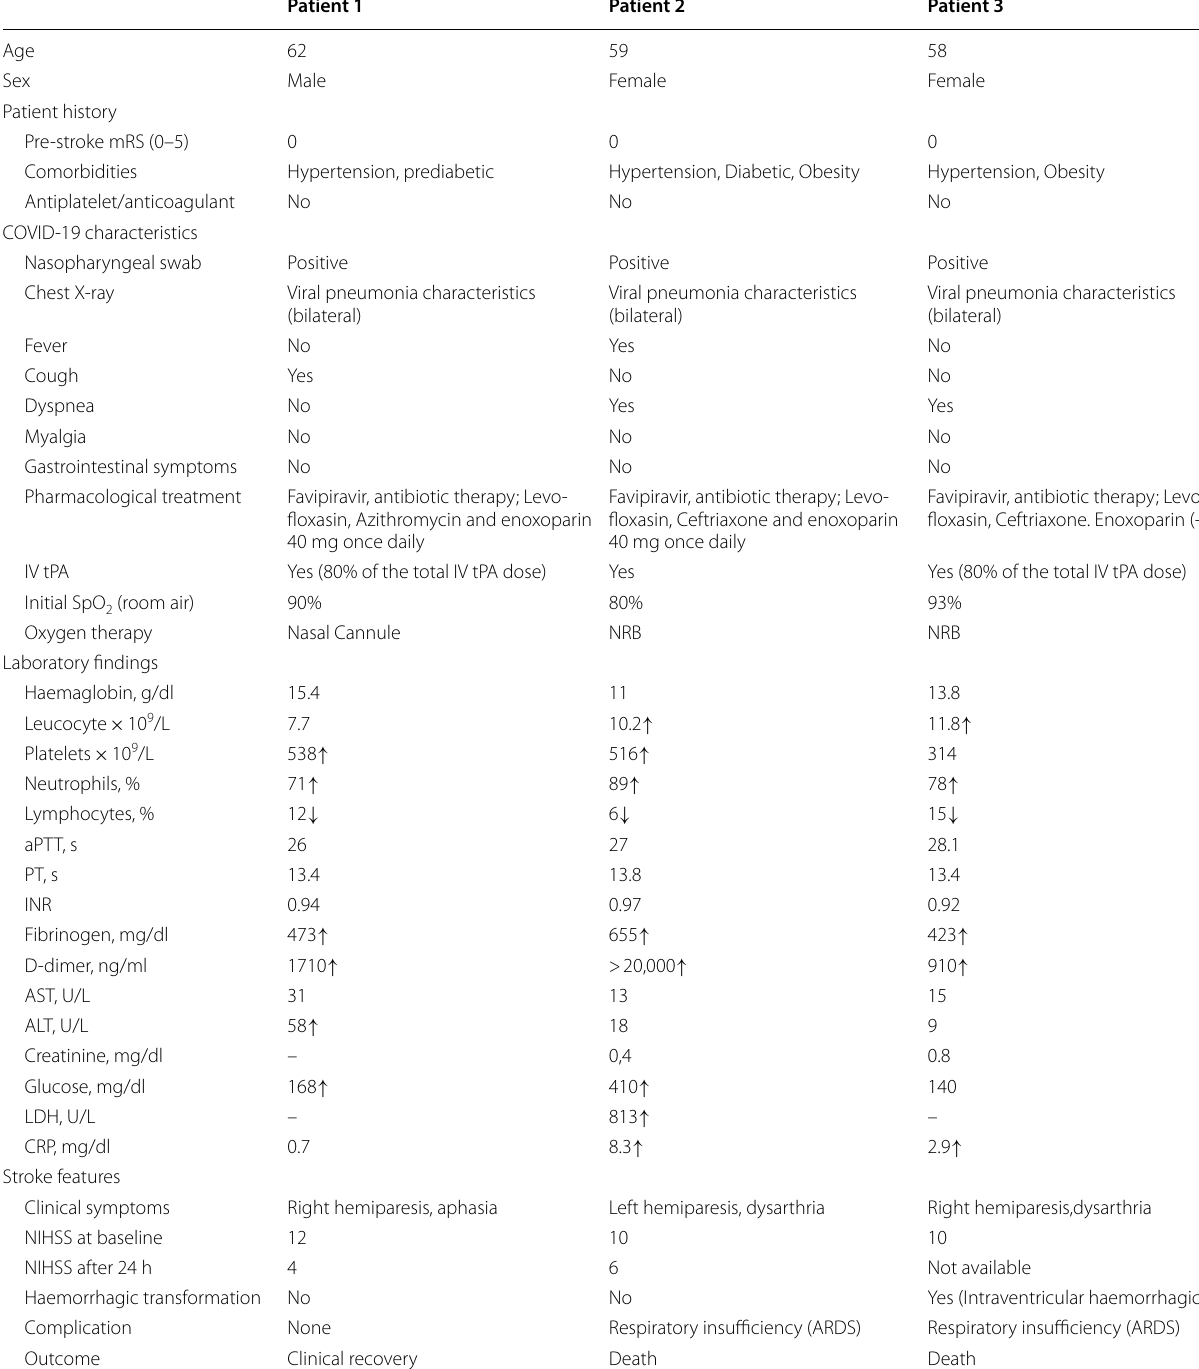
Table 1 Clinical and demographical features of three